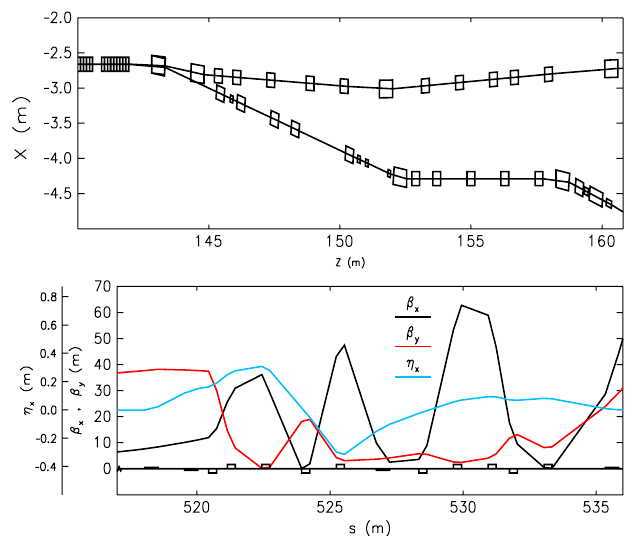
FIG. 9. Top: Floor layout of the extraction region. Bottom: Optics and dispersion functions through the extraction